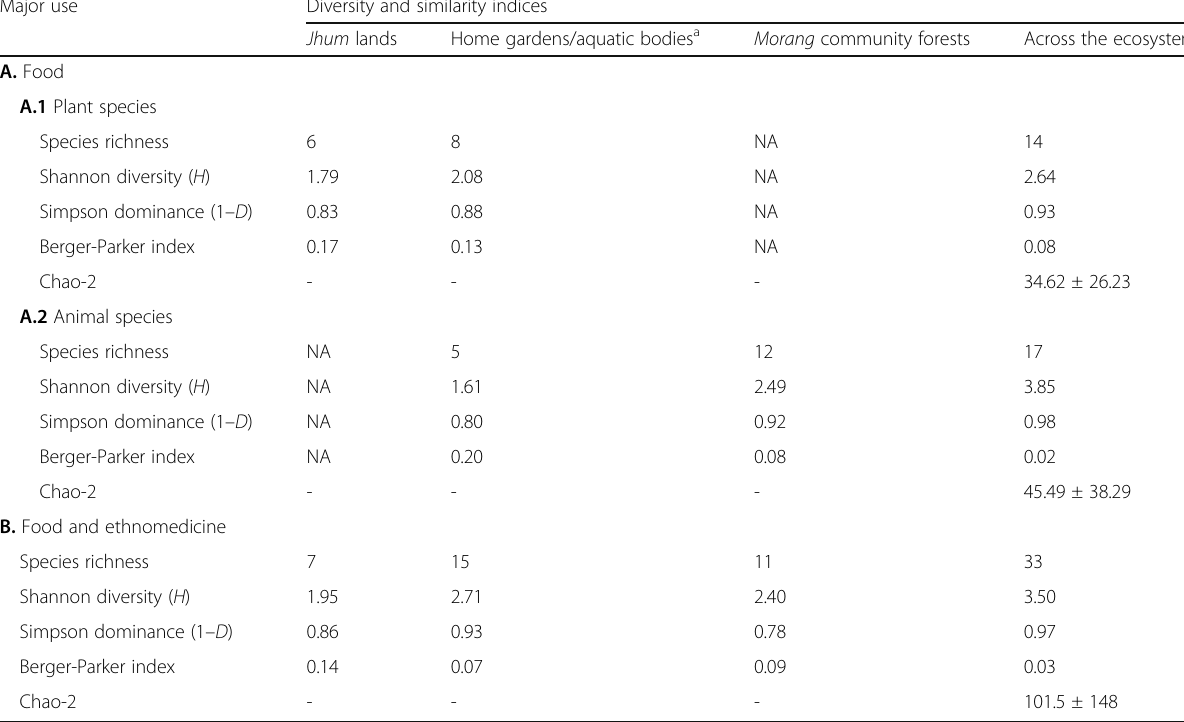
Table 5 Shannon diversity and similarity indices of bio-culturally important food species of Adi Major